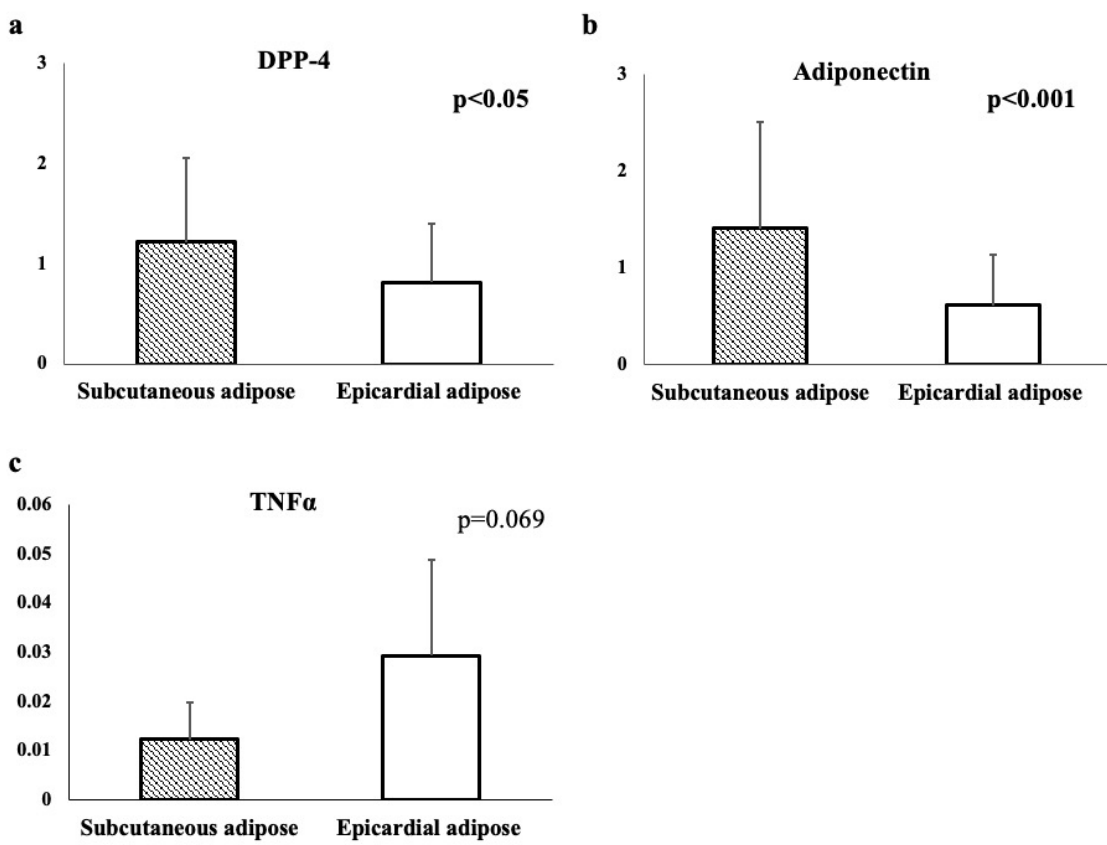
Figure 1. Comparison of dipeptidyl peptidase 4 (DPP-4), adiponectin, and tumor necrosis factor α (TNF α ) expression in subcutaneous and epicardial adipose tissue. ( a ) Expression of DPP-4 in subcutaneous and epicardial adipose tissue. ( b ) Expression of adiponectin in subcutaneous and epicardial adipose tissue. ( c ) Expression of TNF α in subcutaneous and epicardial adipose